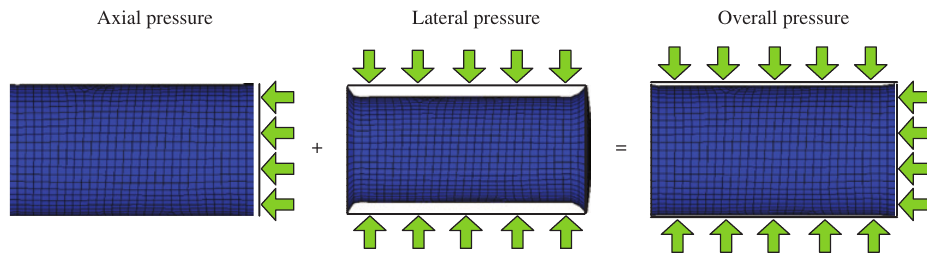
Figure 8: Static deformations under componential pressure (CTM3).